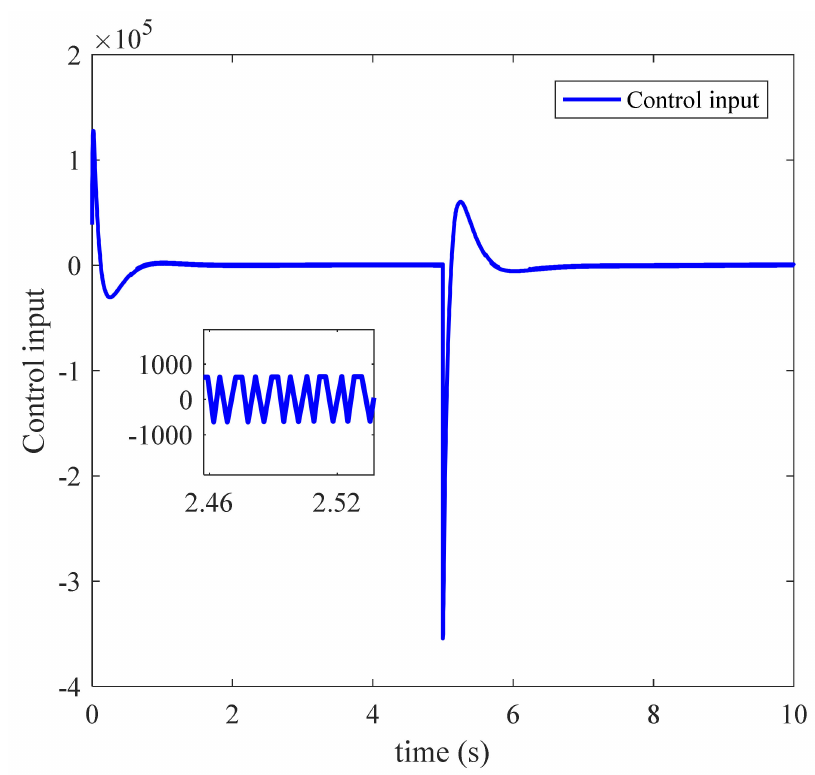
Figure 12. Time response of control input without adaptive fuzzy